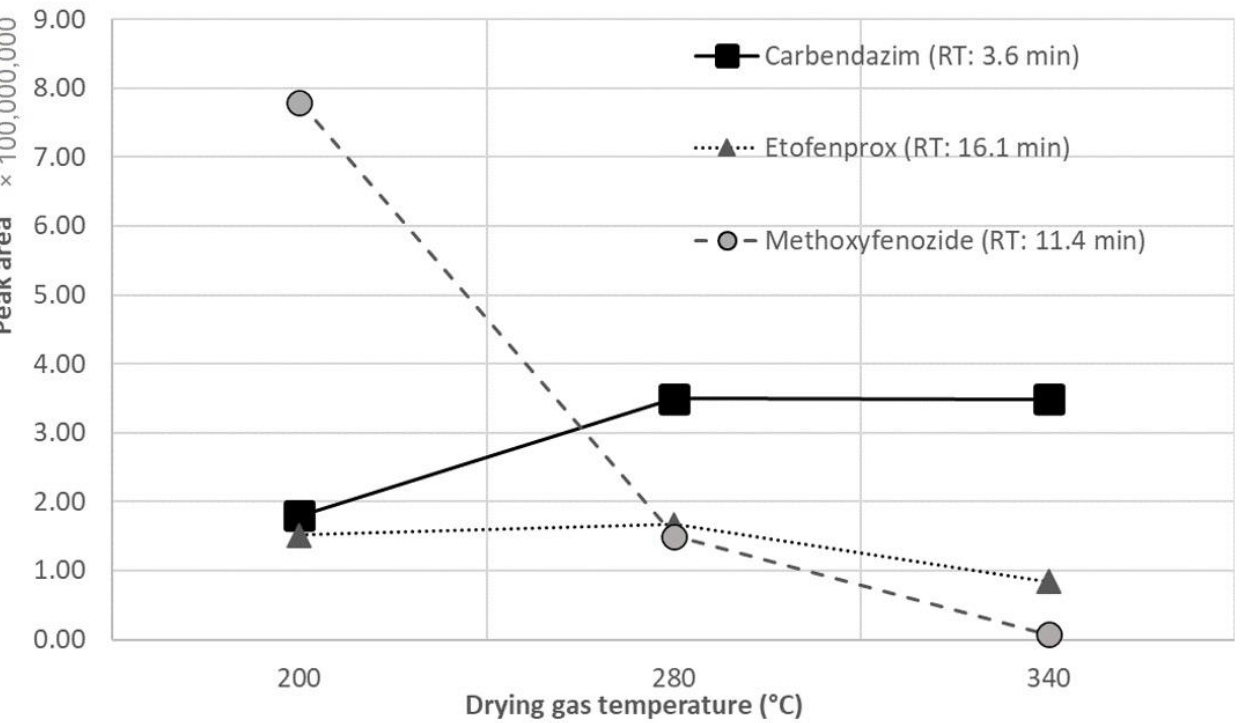
Figure 2. Effect of drying gas temperature in ESI on the sensitivity (as peak area) of three different analytes (carbendazim, methoxyfenozide and etofenprox). RT: retention time ×.